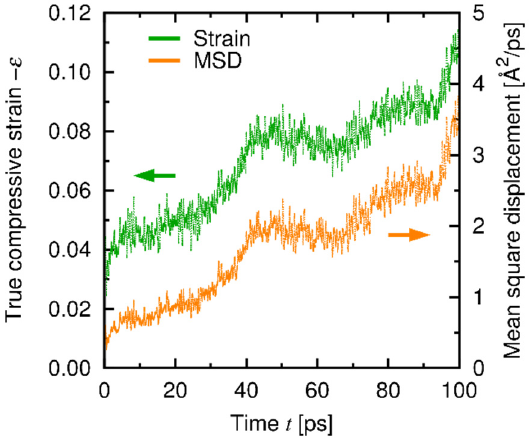
Figure 13. Temporal development of MSD and creep strain at Region I under the σ -constant condition ( σ = 7 GPa, T = 1000 K). The MSD includes the contributions of both Si and C.